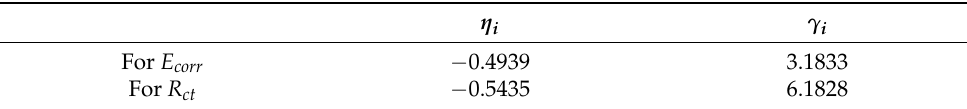
Table 5. Values of the model parameters for E corr and R ct in Equation (5). η i γ i For E corr − 0.4939 For R